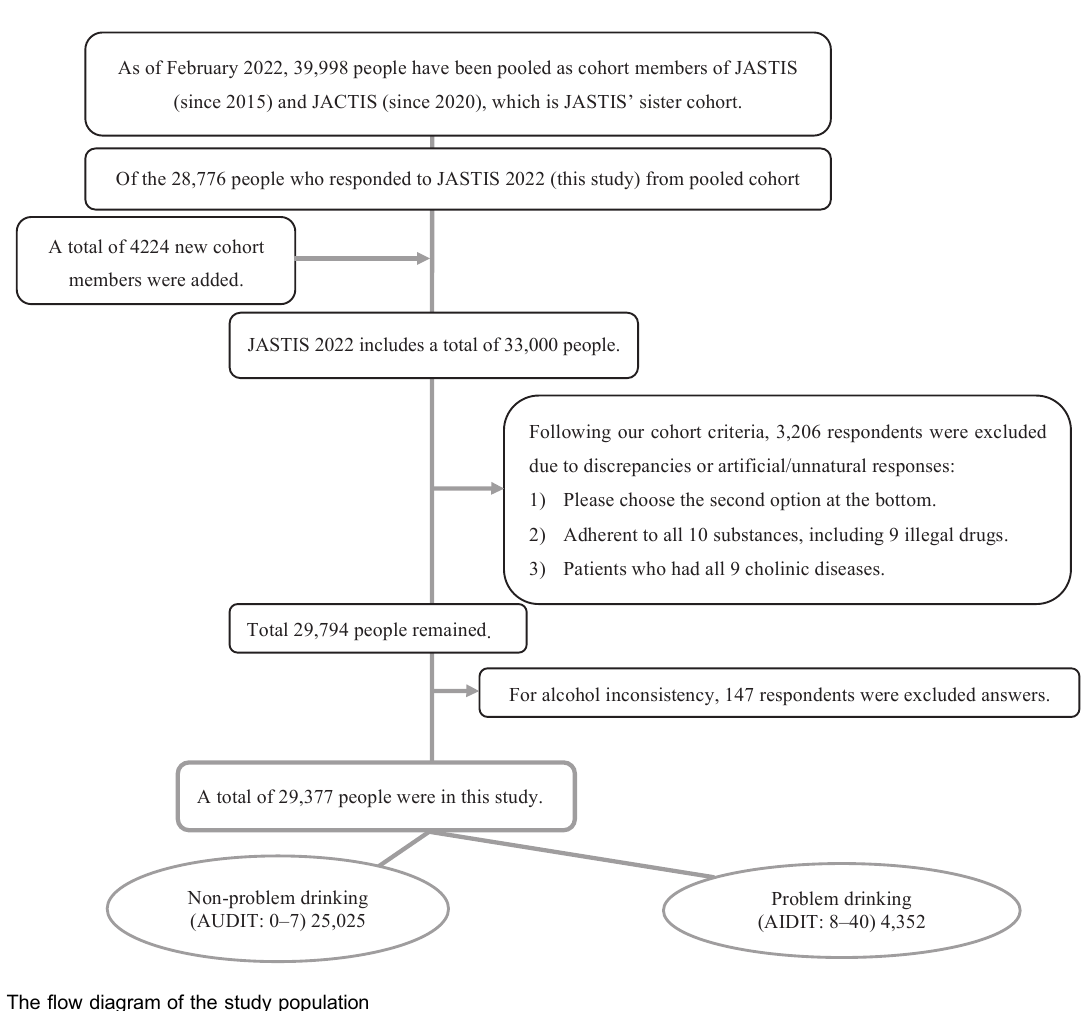
Fig. 1 The fl ow diagram of the study population The fi gure shows the steps used in the selection of the members of this study. Information on the two cohort studies is available on the website: JUSTIS (https: // jastis-study.jp / ), and JACSIS (https: // jacsis-study.jp /